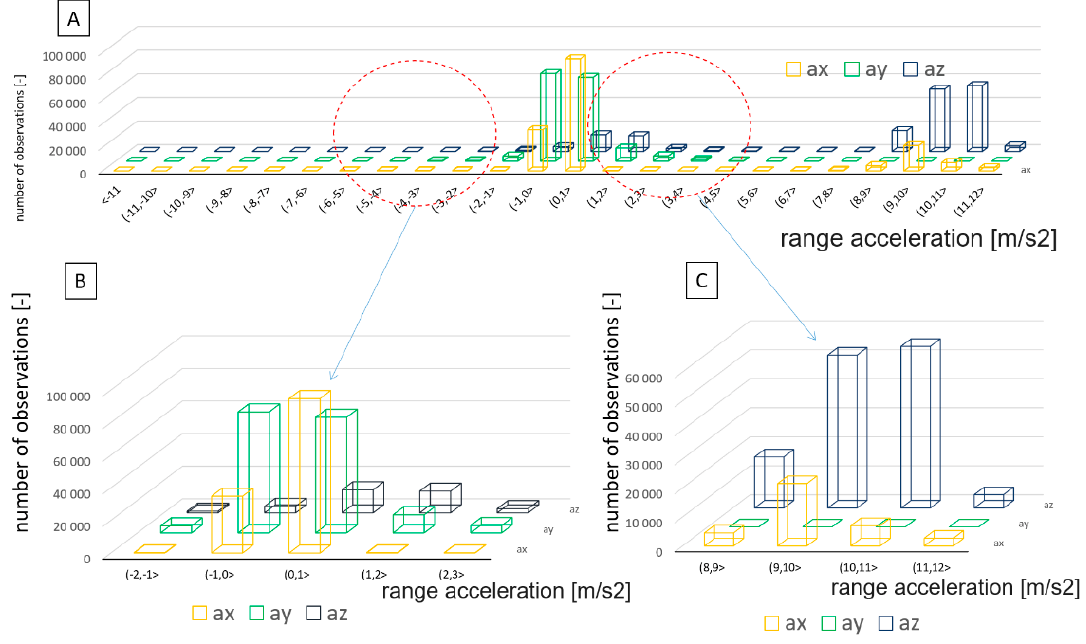
Figure 10. Frequency observation of linear accelerations values: ( A ) /overall distribution ( B ) /distri- bution at low accelerations ( C ) /distribution at high acceleration Source: authors’ own materials.